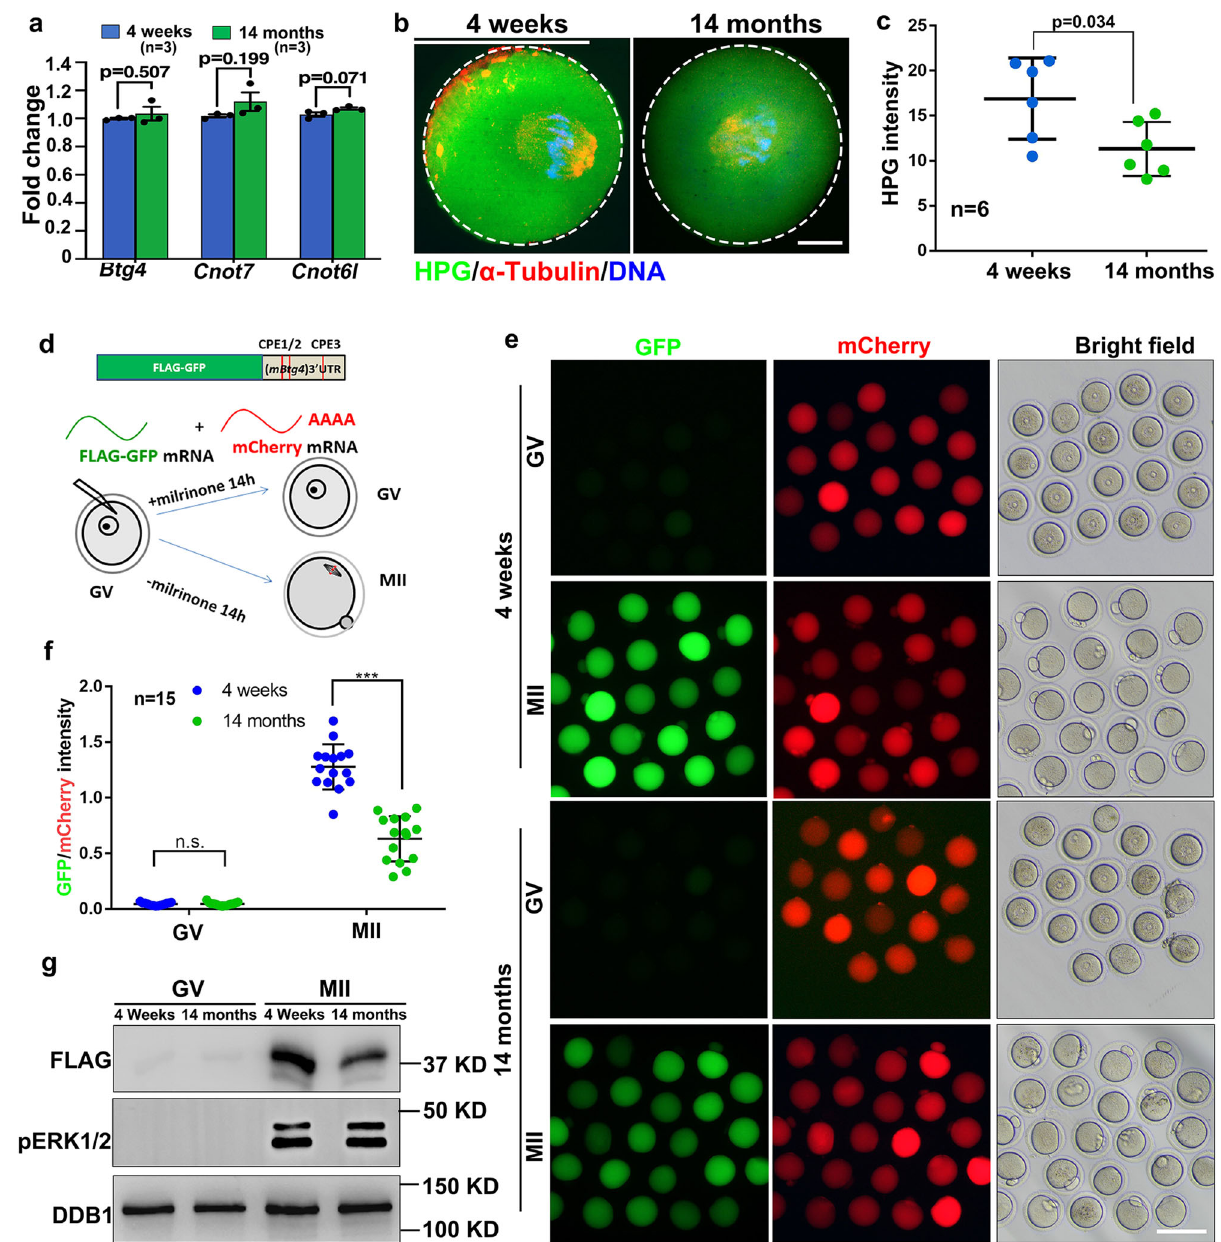
Fig. 7 Age-associated changes of mRNA translation activities in mouse oocytes. a Quantitative RT – PCR results showing the relative levels of the indicated transcripts in GV oocytes derived from 4-week and 14-month mice. n = 3 biological replicates. data are presented as mean values ± SEM. Statistical analysis was performed using two-tailed Student ’ s t -test. n.s.: non-signi fi cant. b HPG fl uorescent staining showing the protein synthesis activity in oocytes derived from 4-week and 14-month mice. Scale bar = 10 µ m. c Quanti fi cation of HPG signals in ( b ). n = 6 oocytes for each experimental group. Data are presented as mean values ± SEM. P by two-tailed Student ’ s t -test. d , f : Illustration ( d ), fl uorescence microscopy ( e ), quanti fi cation of the fl uorescent signals ( f ), and western blot ( g ) results showing the translation activities of the Btg4 3 ′ -UTR in GV-arrested (maintained by milrinone) or MII- arrested (released from milrinone) oocytes. The GFP signal indicated translational activation of the Btg4 3 ′ -UTR. An in vitro transcribed and polyadenylated mCherry mRNA was co-injected as a positive control. Scale bar: 100 µ m ( e ). n = 15 oocytes for each experimental group. Data are presented as mean values ± SEM. P by two-tailed Student ’ s t -test ( f